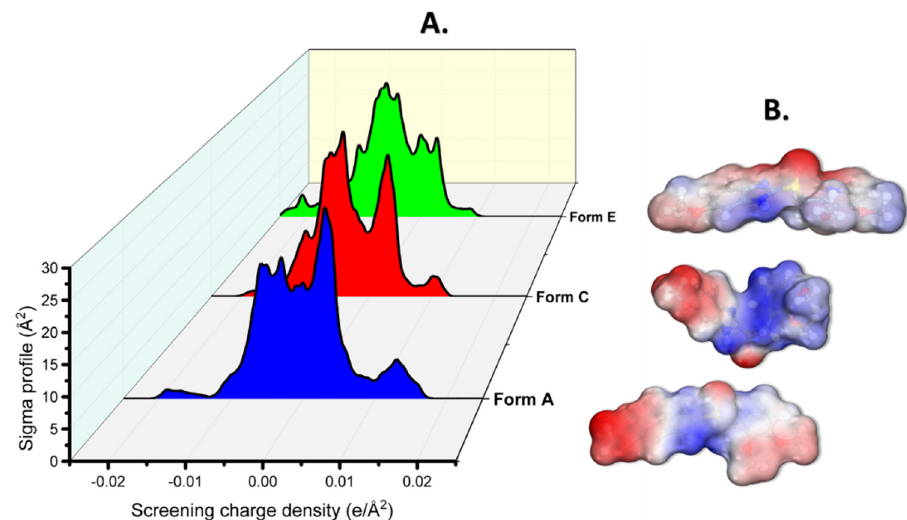
Figure 3. The ( A ) σ -profile and ( B ) 3D COSMO surface for the different protonated forms of a Pantoprazole molecule.